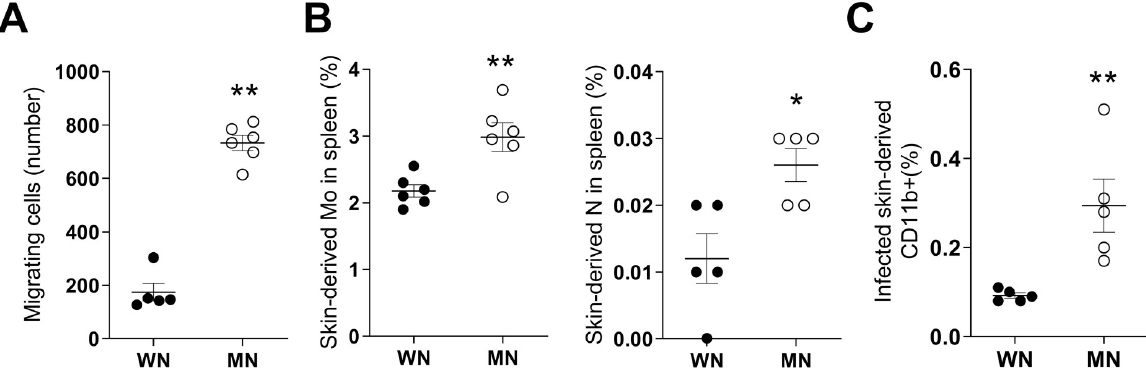
Fig 2. Myeloid cells from malnourished mice have enhanced migratory capacity. A. Ex vivo spontaneous migration of CD11b+ myeloid cells isolated from bone marrow of 72-hour L . donovani -infected well-nourished (WN) or malnourished mice (MN) in a 90-minute transwell assay. Shown as number of total migrating cells. � p = 0.0043 (Mann-Whitney test). B . Percent of skin-derived monocytes (Mo) in spleen (Left panel) and skin-derived neutrophils (N) spleen (right panel) in 72-hour L . donovani -infected WN and MN mice. �� p = 0.006 (Unpaired t-test); � p = 0.047 (Mann-Whitney test). C . Percent of skin-derived infected CD11b+ cells in spleen of WN and MN mice relative to total spleen cells �� p = 0.0098 (Unpaired t-test). Data are from a single flow cytometry experiment. N = 5 mice per